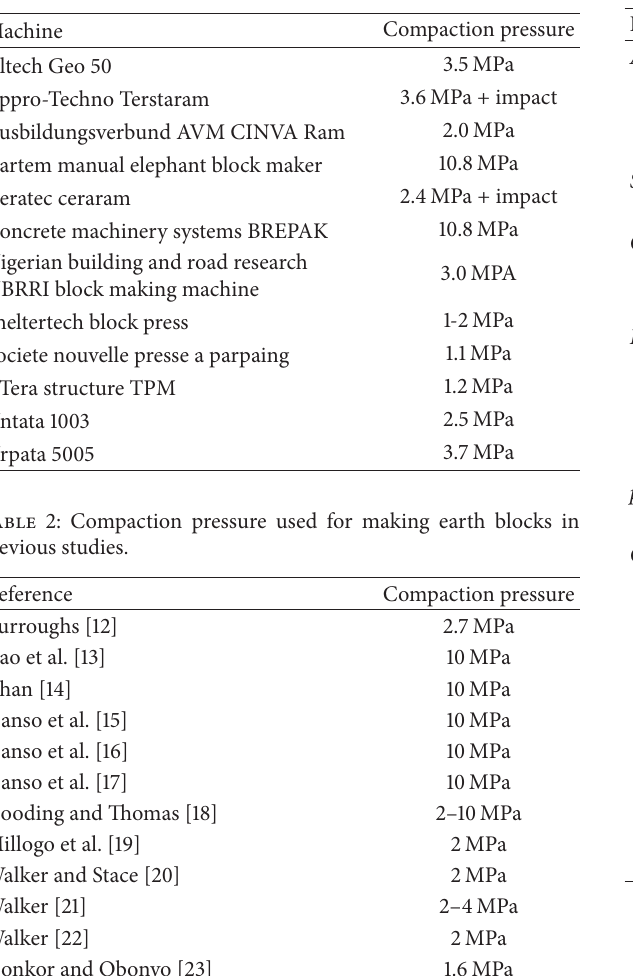
Table 1: Commercial compaction machines and pressure.